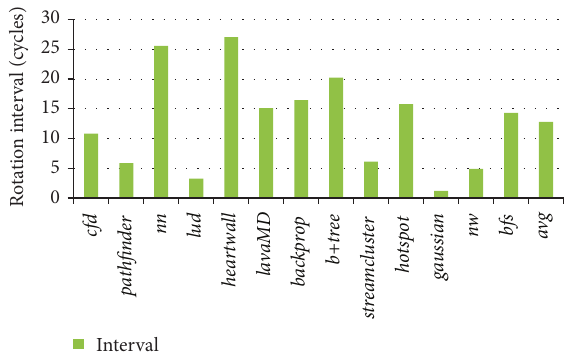
Figure 11: Average rotation interval in